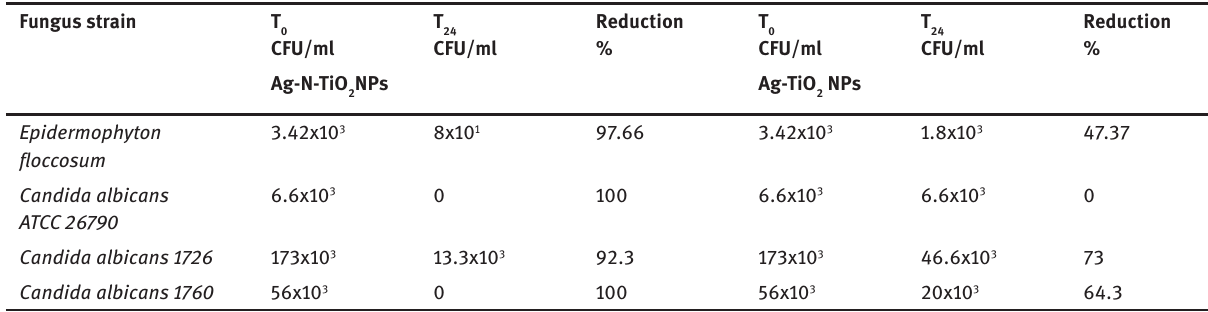
Table 1: The resistance of leather surfaces against Epidermophyton floccosum,Candida albicans ATCC 26790, Candida albicans 1726 and Candida albicans